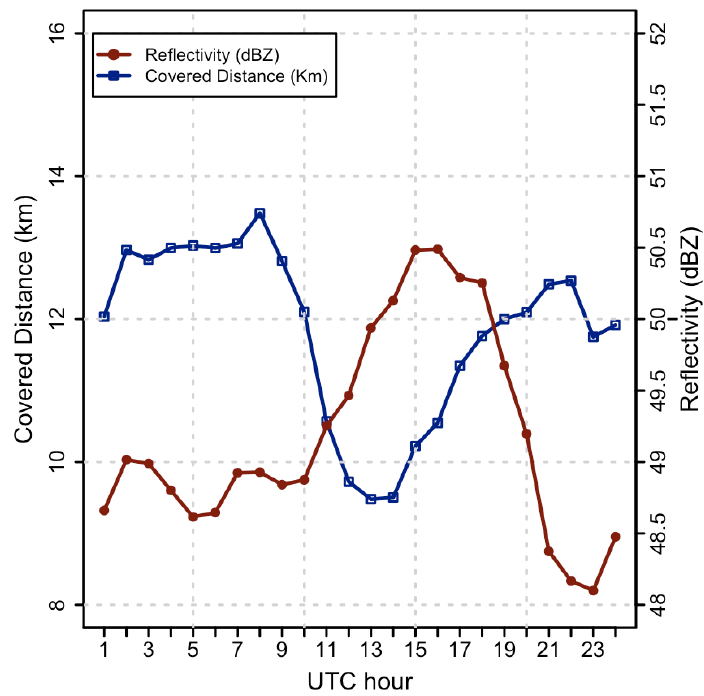
Figure 7. Mean values of maximum reflectivity and distance travelled by the cells as a function of the hour in which the cell has been detected for the first